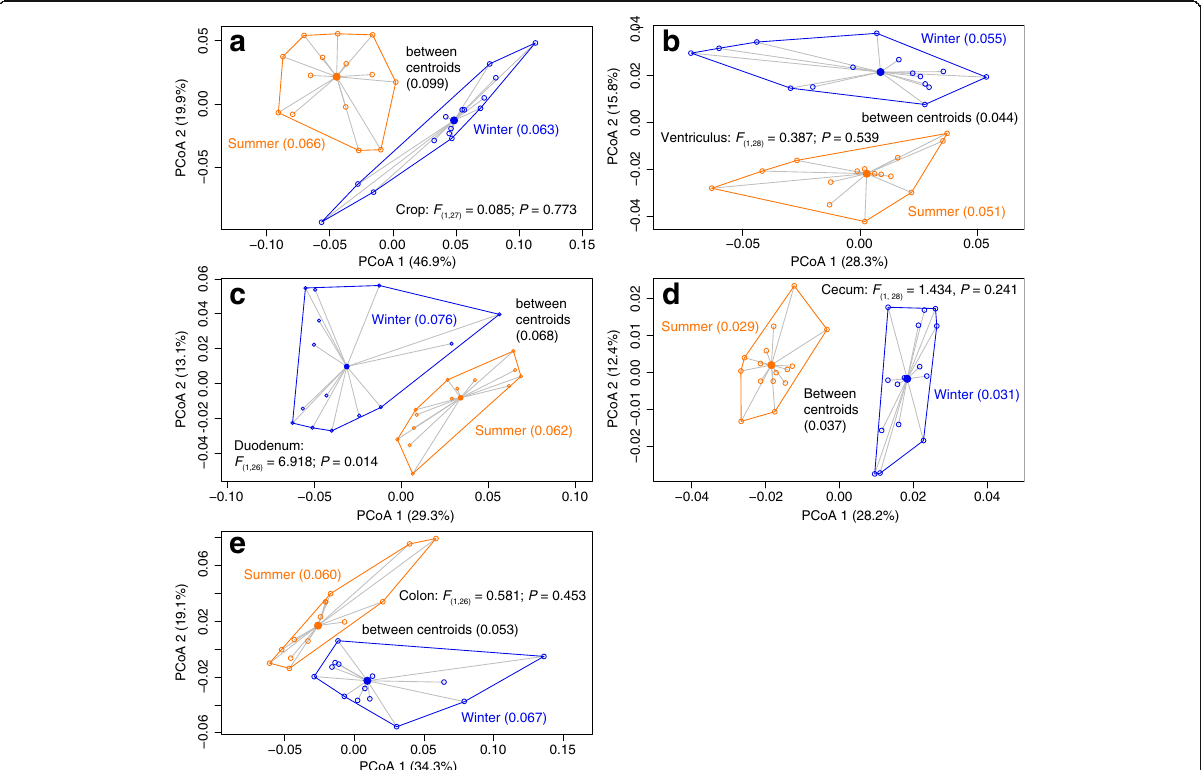
Fig. 6 Plots of principal coordinate analyses based on weighted UniFrac distances among individual samples within each gut region: ( a ) crop, ( b ) ventriculus, ( c ) duodenum, ( d ) cecum, ( e )